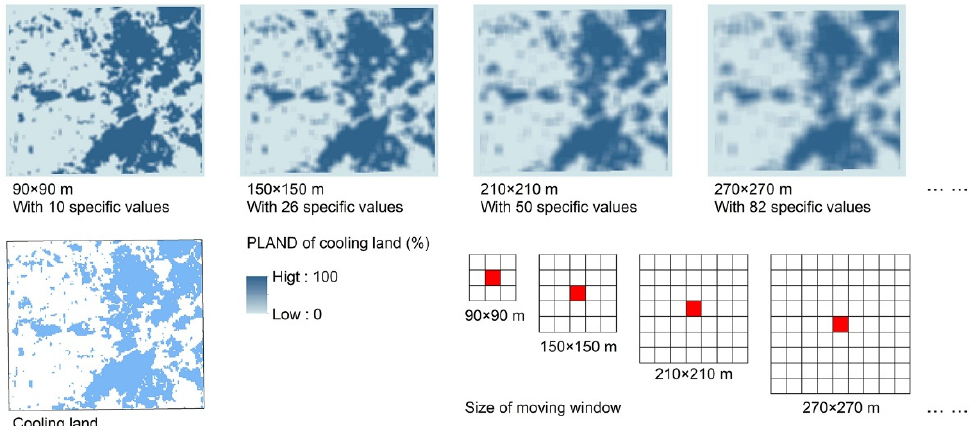
Figure A3. The determination of the moving window size. The side length of the moving window should be an odd multiple of 30 m based on the spatial resolution of remote sensing images, and the continuity of the value of land coverage calculated with small windows (such as 90 × 90 m and 150 × 150 m) was too weak to perform the corresponding analysis of LST while the land coverage layer calculated with large windows (270 × 270 m and above) lost a lot of spatial details that also reduced the accuracy of the analysis. A 210 × 210 m window was thus selected finally.